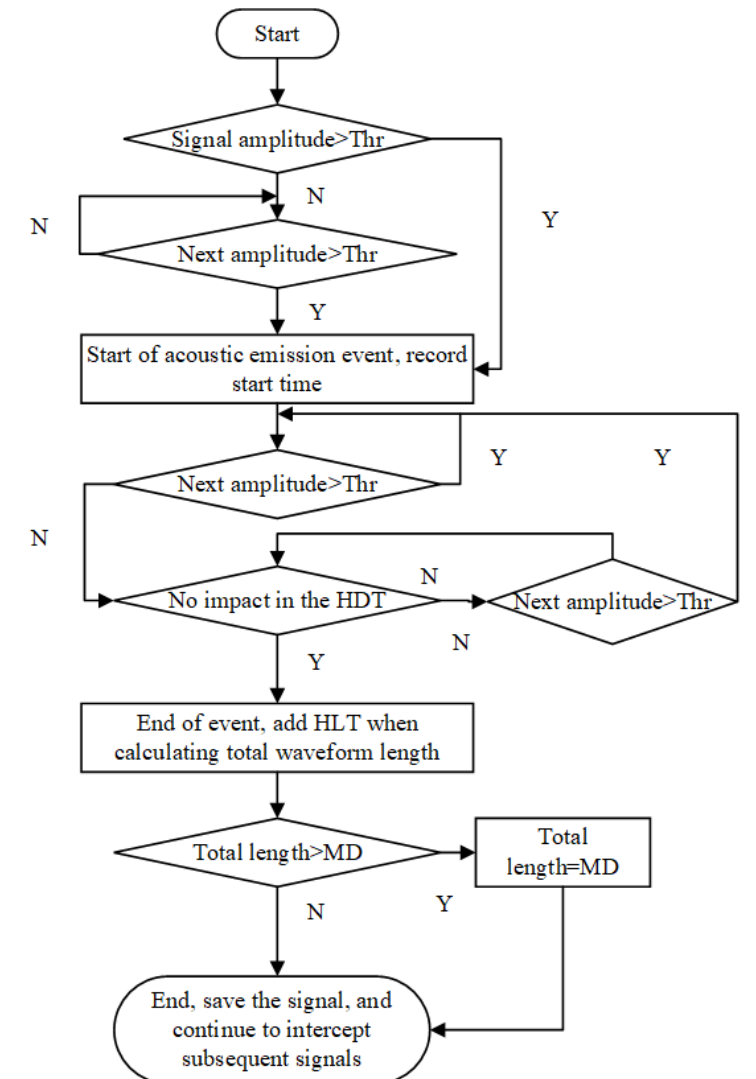
Figure 2. Flow chart of acoustic emission signal segmentation algorithm.